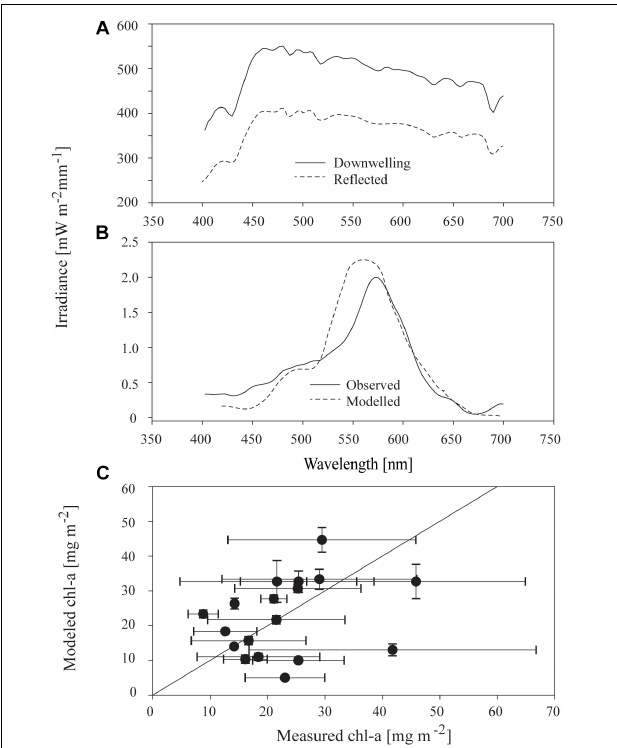
FIGURE 6 | (A) Incident downwelling and reflected irradiance spectrum at the surface of sea ice at a representative sample site free of snow; (B) observed irradiance spectrum 10–15 cm underneath the sea ice, and modeled irradiance; and, (C) relationship between measured chl-a and modeled chl-a at the 18 stations for which sufficient data were available. Modeled chl-a is defined as the concentration necessary to reproduce the observed under-ice irradiance spectrum using the optical model. Points and bars are the mean and standard deviation of the three replicate samples at each of 20 stations and the solid black line is the 1:1 line between the two